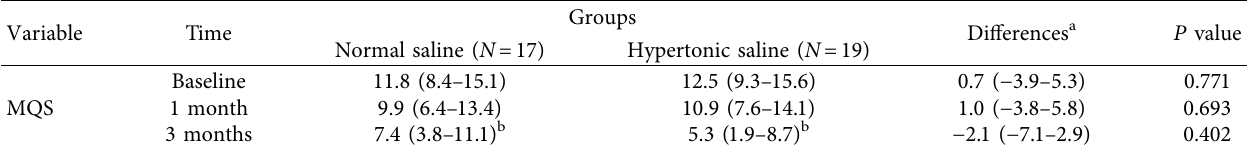
Table 4: Changes in the estimated medication quantifcation scale after epidural block with or without hypertonic saline in patients with postherpetic neuralgia.